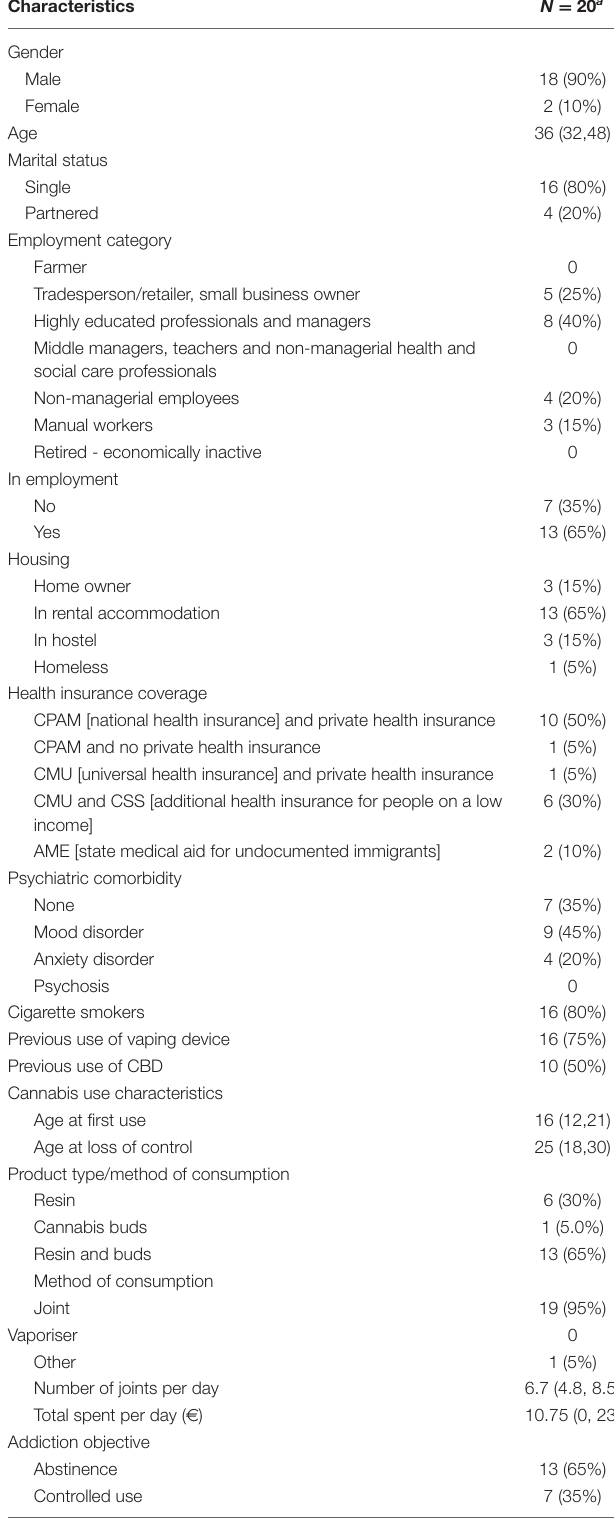
TABLE 1 | Participant